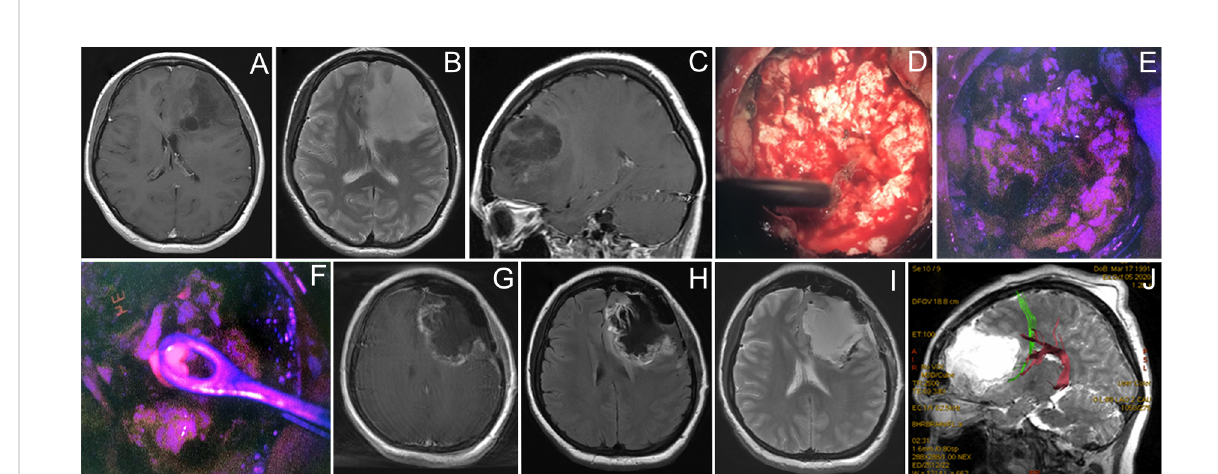
FIGURE 5 Case 5. A 29-year-old woman with left frontal non-enhancing glioma with a focus of intratumoral fl uorescence. Preoperative contrast- enhanced T1 axial (A) , T2 axial (B) , and contrast-enhanced T1 sagittal MR images showing the tumor (C) . Intraoperative photos of the tumor bulk in the white mode (D) and fl uorescence mode (E) image demonstrate dim pink fl uorescence. A spot of bright fl uorescent tissue was identi fi ed (F) and taken for biopsy. Postoperative T1 contrast-enhanced (G) , T1 (H) , and T2 (I) MR images demonstrate partial tumor